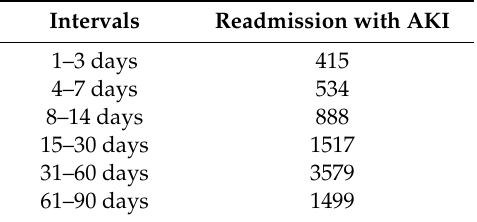
Table 3. The number of AKI cases are grouped into six time